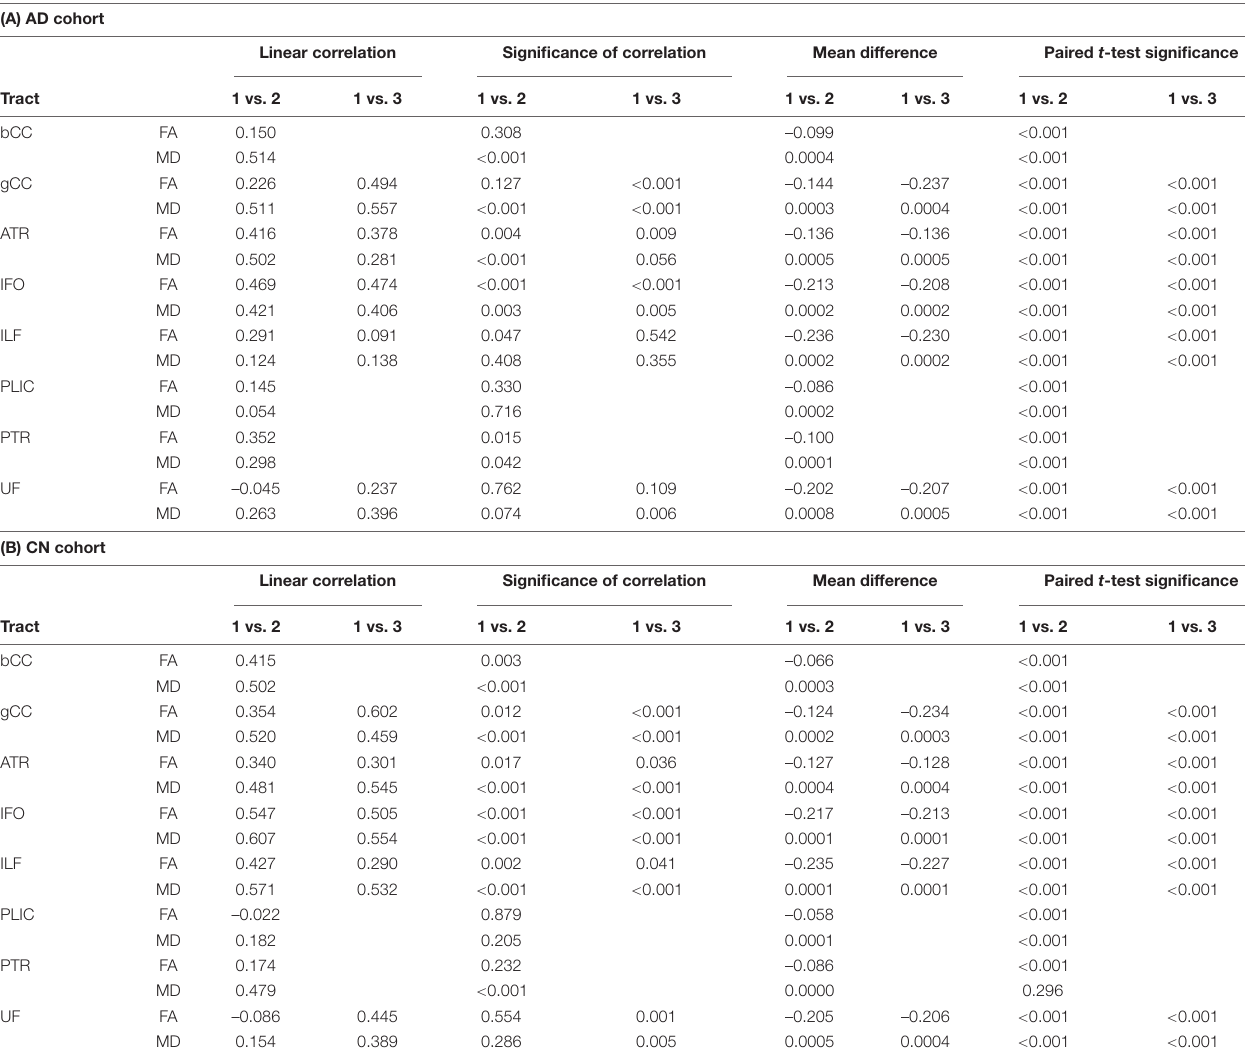
TABLE 2 | Comparison of FA and MD derived by Method 1 against Methods 2 and 3 (non-ACPC aligned and co-registered) across white matter tracts in the (A) Alzheimer’s disease cohort and (B) cognitively normal